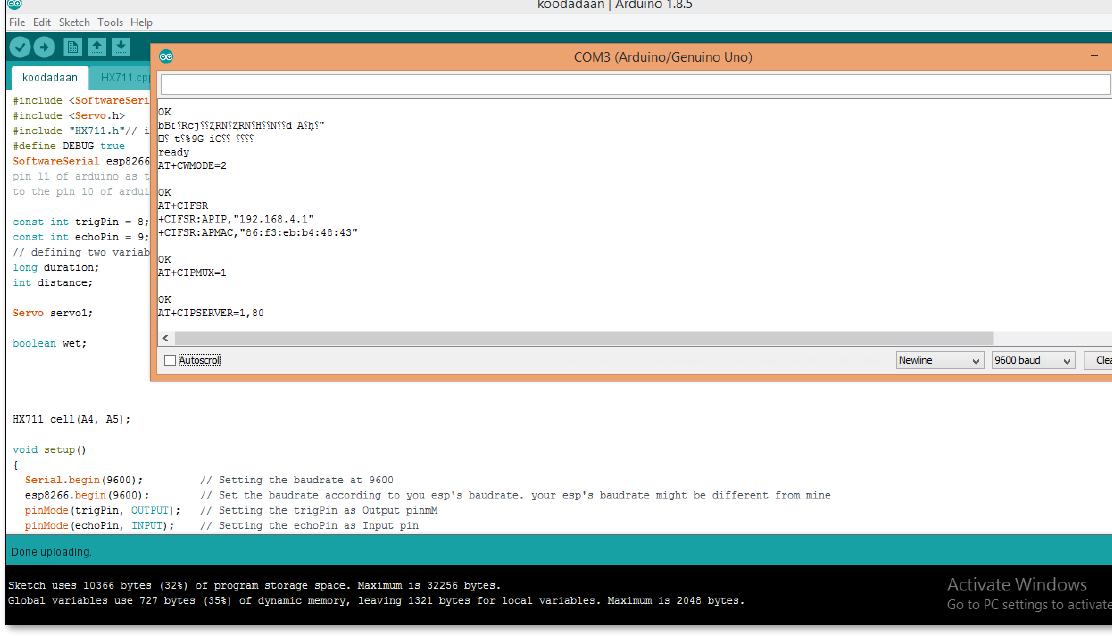
Figure 14. Distance measuring sensor placed on the inner lid of smart bin.